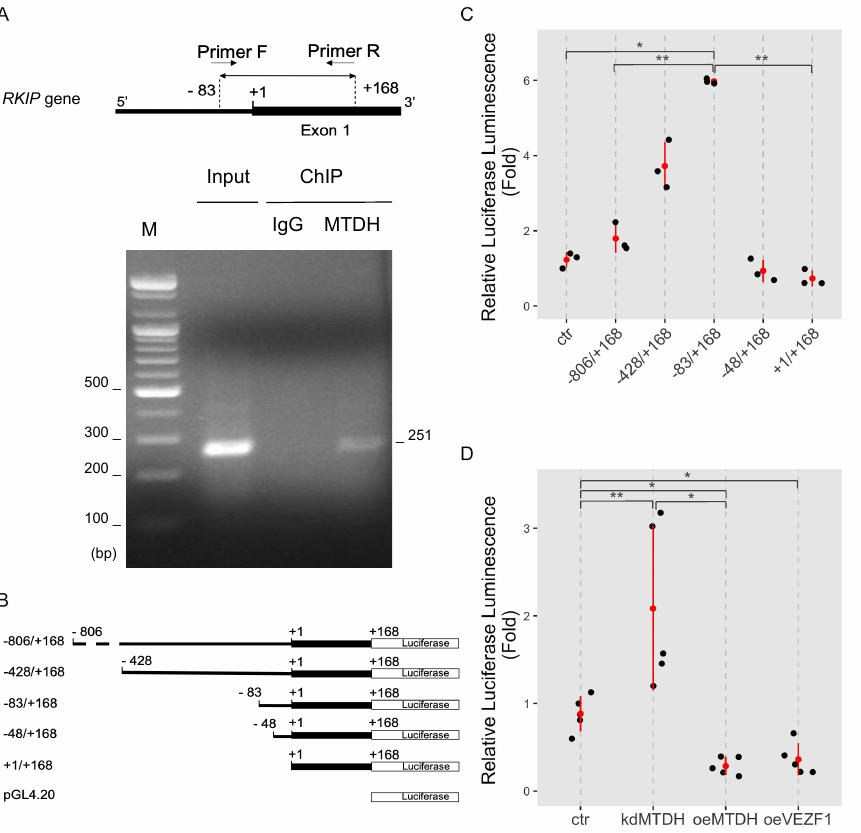
Figure 4. MTDH binding to the RKIP promoter. ( A ) Chromatin immunoprecipitation (ChIP) assay. MCF-7 cells were double cross-linked with DSG and 4% formaldehyde and lysed with sonication. DNA fragments were immunoprecipitated with anti-MTDH antibodies (MTDH) or IgG as a negative control (IgG). Specific DNA fragments were amplified with a pair of primers. For input control, either none or purified DNA fragments were amplified. PCR primers used for ChIP assay were created to specifically amplify a 256 bp-DNA fragment (from − 83 to +168 on the upstream region of RKIP gene, as shown in the top of (A). Amplified DNA fragments were separated on a 1% agarose gel and visualized by EtBr staining. The first lane indicates 100 bp size markers. ( B ) A schematic illustration of the constructs for the luciferase RKIP promoter assay. The serially deleted RKIP promoter DNA fragments ( − 806/+168, − 428/+168, − 83/+169, − 48/+168, and +/+168) were inserted into the pGL4.20 luciferase vector. ( C ) The RKIP promoter activity. The relative luciferase activities were determined in MCF-7 cells transfected with serially deleted constructs of the RKIP promoter. Data represent fold-changes from three independent experiments. ** <0.01, * <0.05 p -value. ( D ) RKIP promoter activity upon modulating MTDH expression. MCF-7 cells were transfected by none ( ctr ), shMTDH ( kdMTDH ), FLAG-MTDH ( oeMTDH ), or VEZF1 plasmids ( oeVEZF1 ) and used in luciferase assay with the RKIP promoter − 83/+168 construct. Data represent fold changes from five independent experiments. ** <0.01, * <0.05 p